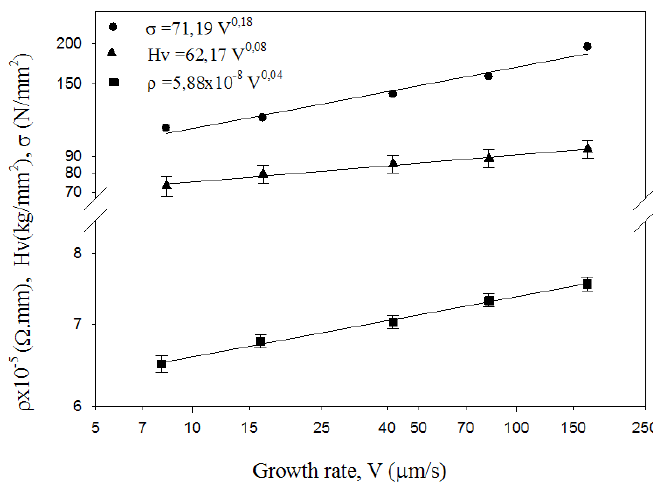
Fig 4. Variation of microhardness (HV), tensile strength (σ) and electrical resistivity (ρ) vs. growth